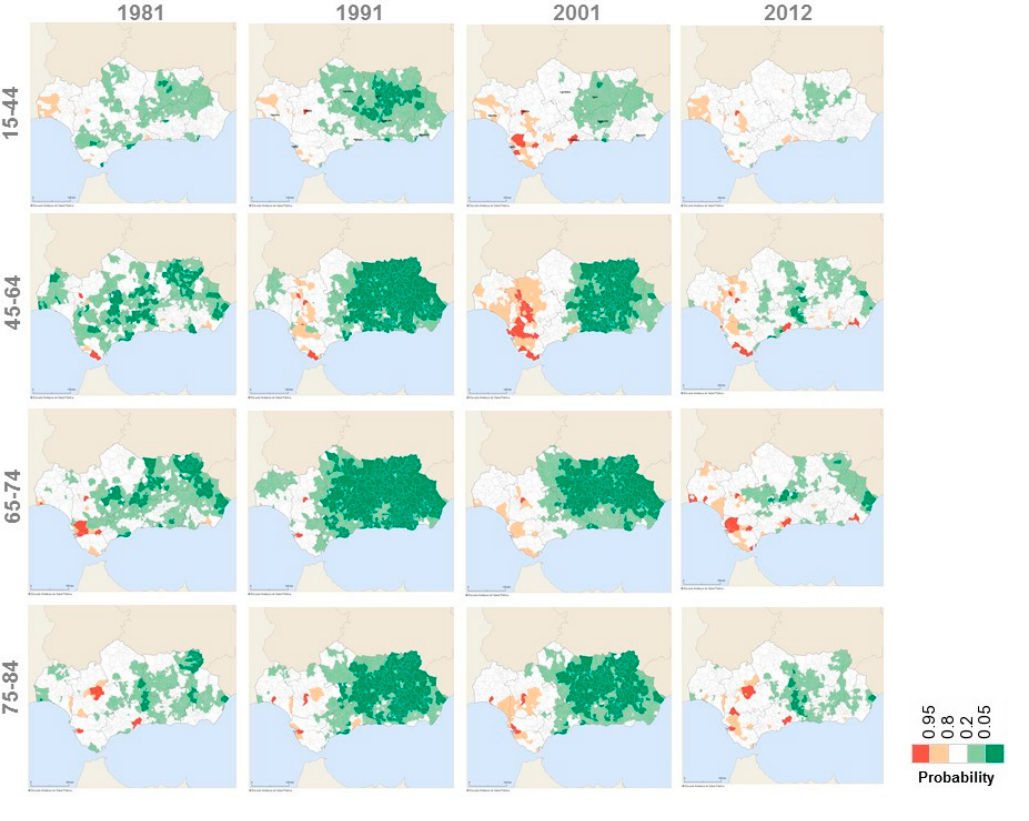
Figure 6. Geographical variations of the probability that the age-specific mortality rate ratio in each Andalusian municipality is greater than 1 using Spain as the reference, 1981–2012.